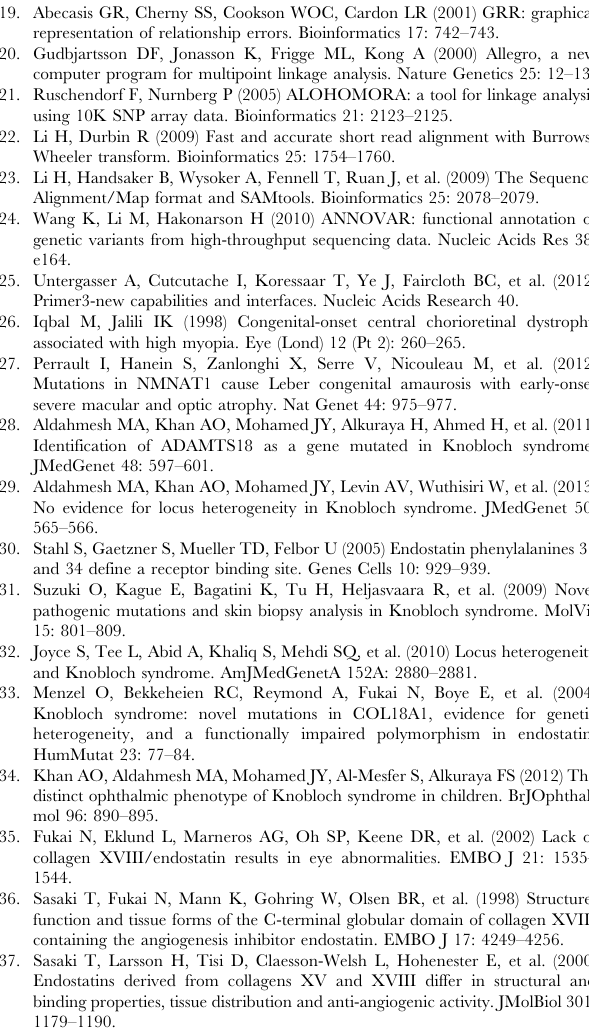
20,044 selected SNP markers from the Affymetrix SNP Array 6.0. LOD scores (y-axis) were calculated using ALLEGRO and plotted against the genetic distance in cM (centi Morgan) on the x-axis, which is used as a surrogate for the genomic position. Chromosomes are concatenated from p-ter to q-ter from left to right. Table S1 Homozygous regions in patient IV-1 obtained by linkage analysis and subtracting common homozy- gous regions from